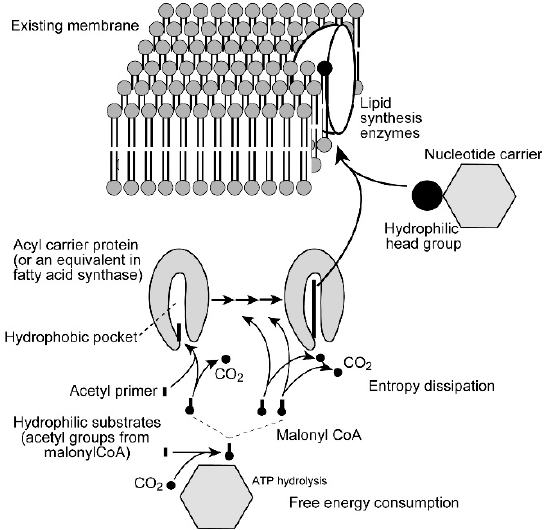
Figure 7. Fatty acid synthesis and biosynthesis of biomembrane. Fatty acids in membrane lipids are composed of 16 or 18 carbon atoms (14 or 16 methylene groups plus methyl and carboxyl groups), and synthesized by condensing C2 units. The hydrophobic chain of growing fatty acid is encapsulated in the hydrophobic pocket of acyl carrier protein. The condensation reaction is performed with dissipating entropy in the form of carbon dioxide, originally attached to the C2 unit via hydrolysis of ATP. Reduction of acyl chain by NADPH is not explicitly shown in the figure. The synthesized fatty acid is transferred to glycerol phosphate in the membrane to form phosphatidic acid, which is then dephosphorylated to diacylglycerol. Hydrophilic head group is transferred to either phosphatidic acid or diacylglycerol (depending on lipid to synthesize) to form an amphiphilic lipid molecule. See text for details.